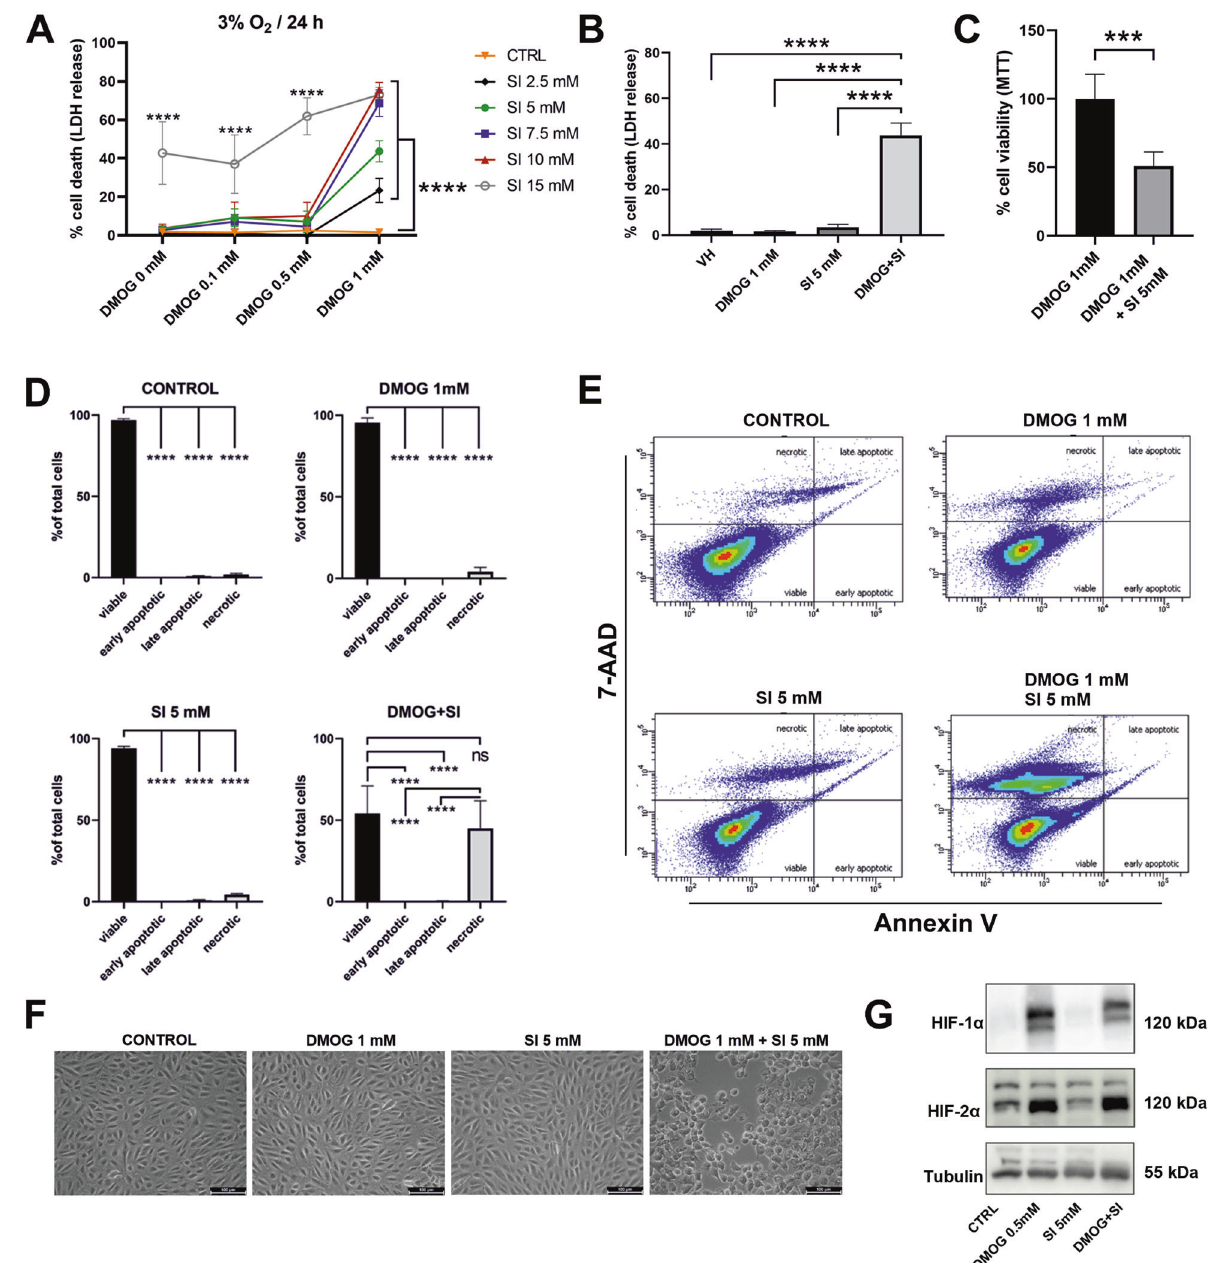
Fig. 1 HIF stabilization aggravated SI-induced cell death in ARPE-19. A ARPE-19 cells were treated with different concentrations of SI, DMOG or a combination of both compounds for 24 h under 3% O 2 and cell death was assessed by measuring LDH release ( N = 5-6). B A subset of LDH data showing cell death in ARPE-19 cells treated with 1 mM DMOG, 5 mM SI, and co-treatment with DMOG and SI where approximately 50% of cells were dead after 24 h ( B ). Cell death rate was further con fi rmed by C MTT assay and D FACS Annexin V assay. E Histograms of FACS Annexin V-PE and 7-AAD stained cells treated with DMOG and/or SI. F Microscopic evaluation con fi rmed advanced cell death by co-treatment with 1 mM DMOG and 5 mM SI. G HIF-1 α and -2 α protein levels were increased by DMOG treatment as well as co- treatment with SI for 24 h under 3% O 2 . Data are presented as means + SD. LDH, MTT, and FACS assays (5 – 6 independent groups) were statistically analyzed with two-way ANOVA, t -test, and one-way ANOVA, respectively. ns = not signi fi cant, *** p < 0.001, and **** p < 0.0001. Scale bar = 100 μ